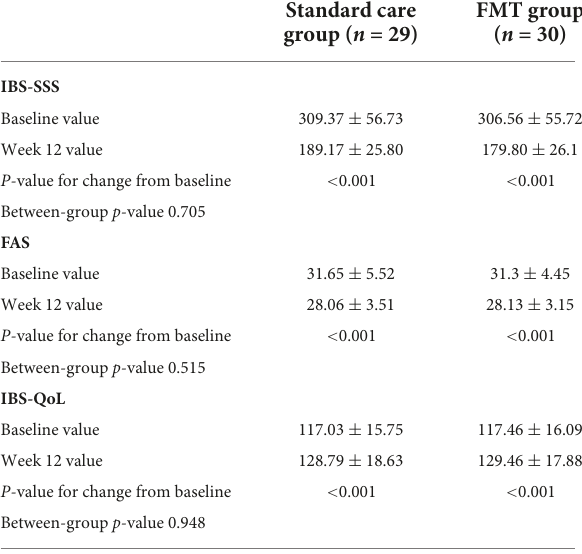
TABLE 3 Outcomes compared within and between